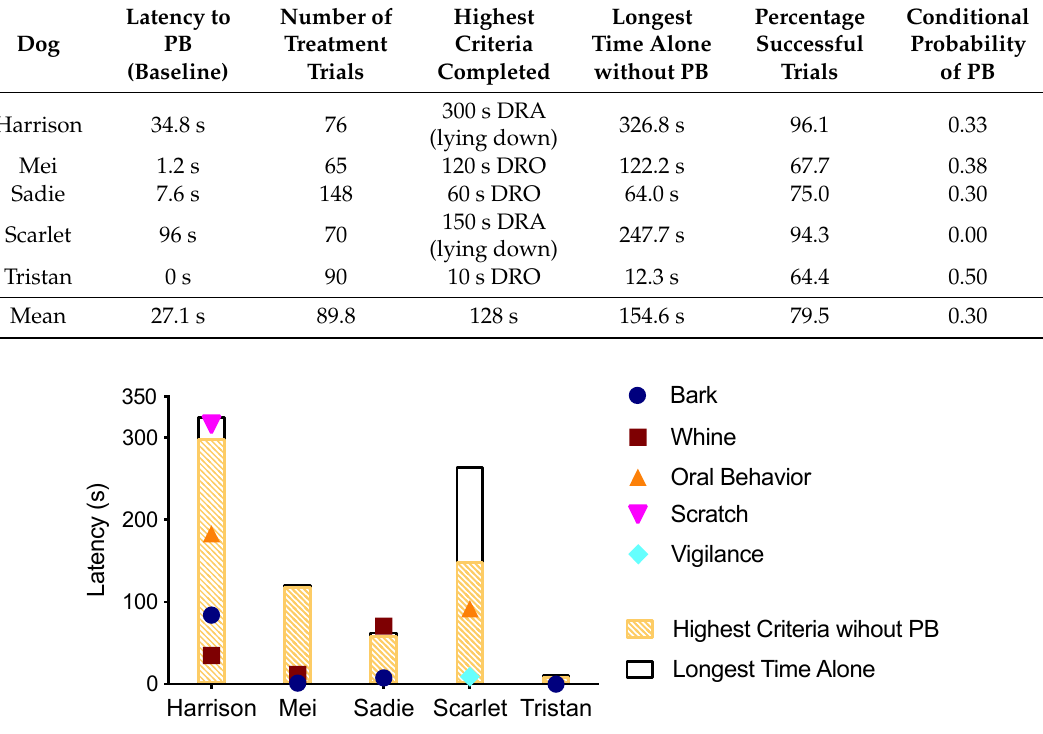
Figure 2. Highest criteria reached (hatched bars) and longest amount of time alone without PB (open bars) during Treatment for each dog. Symbols indicate latency to specific PB for each dog as observed in Baseline.